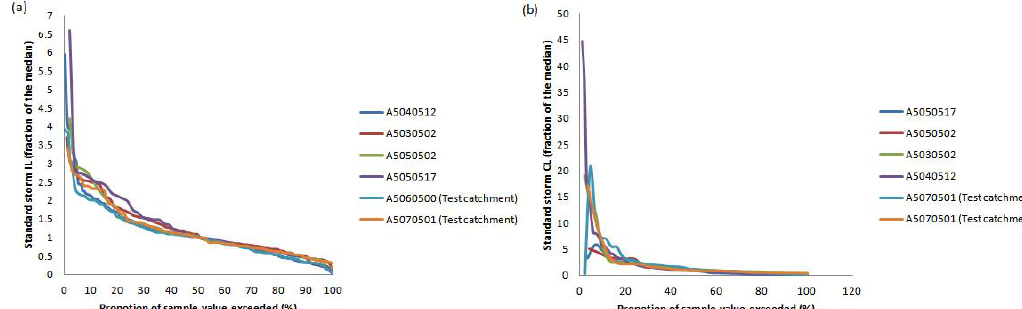
Fig. 7. IL and CL standardised by median